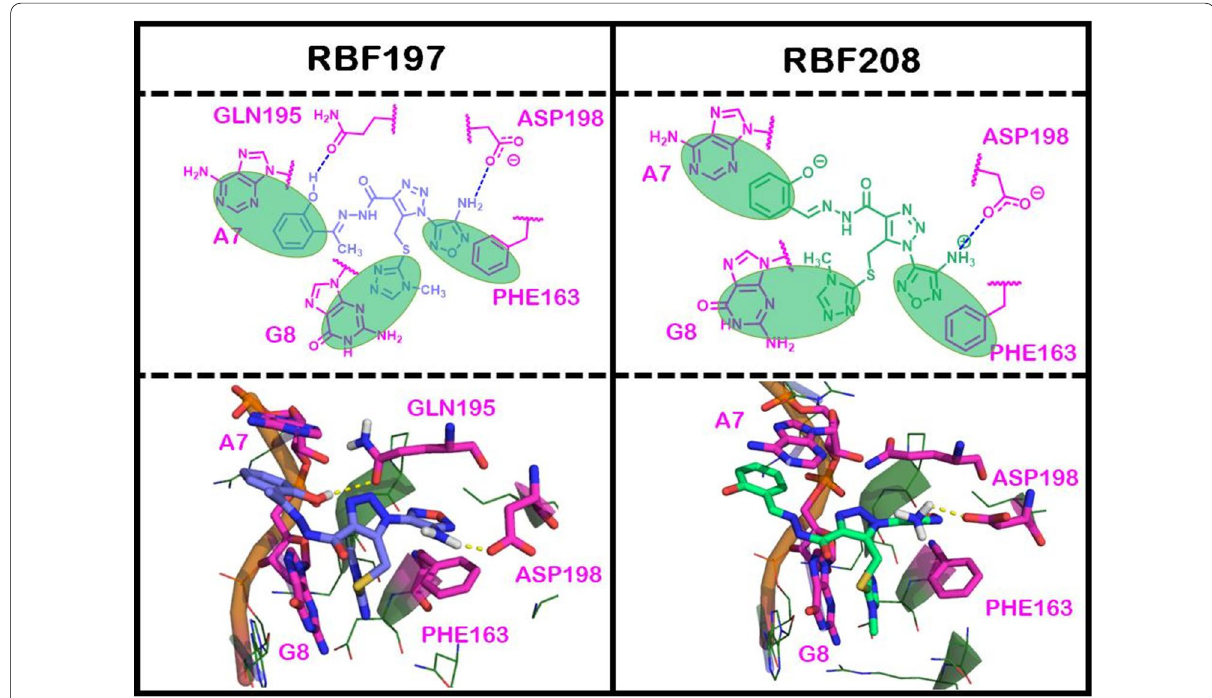
Fig. 7 Docking poses of RBF197 and RBF208 in eIF4A:RNA groove. The top two panels show schematic representations of the interactions made between docked poses of RBF197 and RBF208 and their surrounding environments. Green, transparent ovals are used to two-dimensionally represent possible π-π stacking interactions between the ligands and surrounding residues. Dashed lines between the ligands and surrounding residues are used to indicate hydrogen bonding, where the color indicates the donor/acceptor character of the ligand atom (blue red acceptor). The lower two panels are high-scoring docked models of RBF197 and =